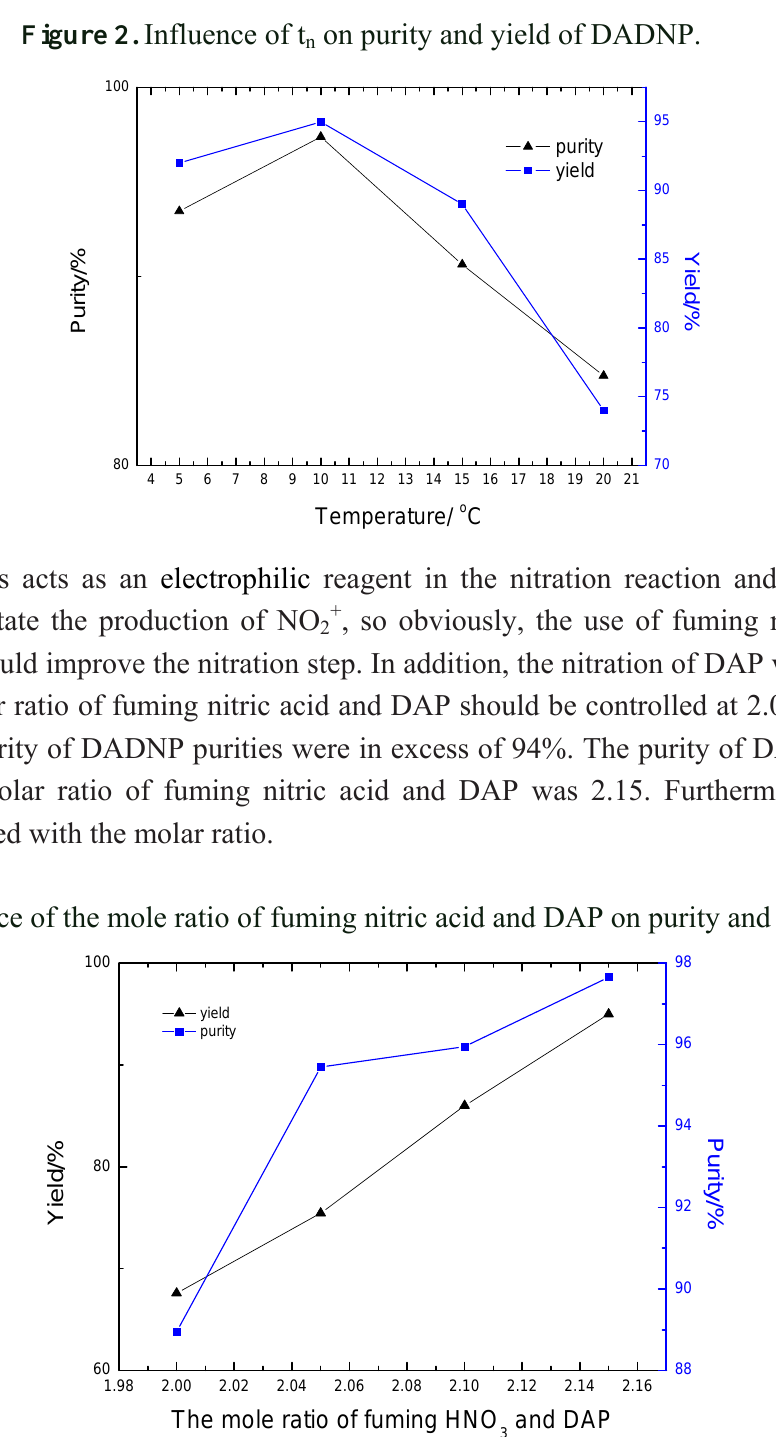
Figure 2. Influence of t